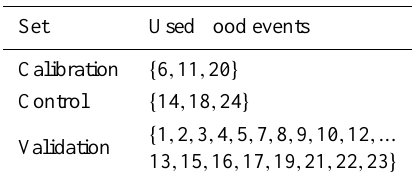
Table 5. Sub-division of all flood events in a calibration, control and validation